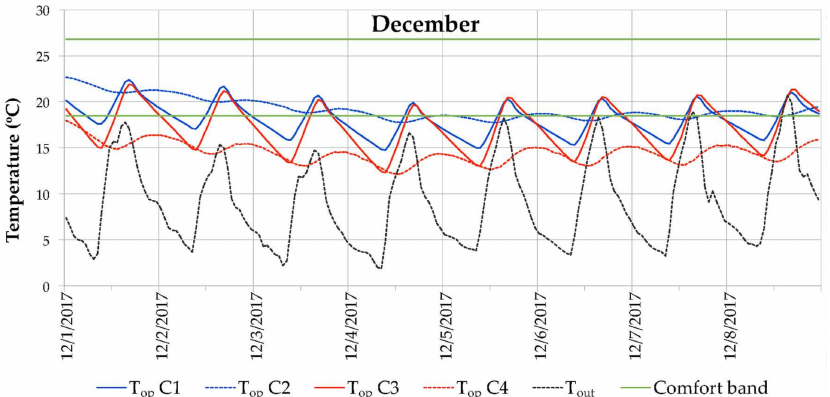
Figure 7. December protocol (no ventilation): Daily evolution of operative temperatures in each cell compared to outdoor temperatures (see Supplementary Materials Figure S1c).